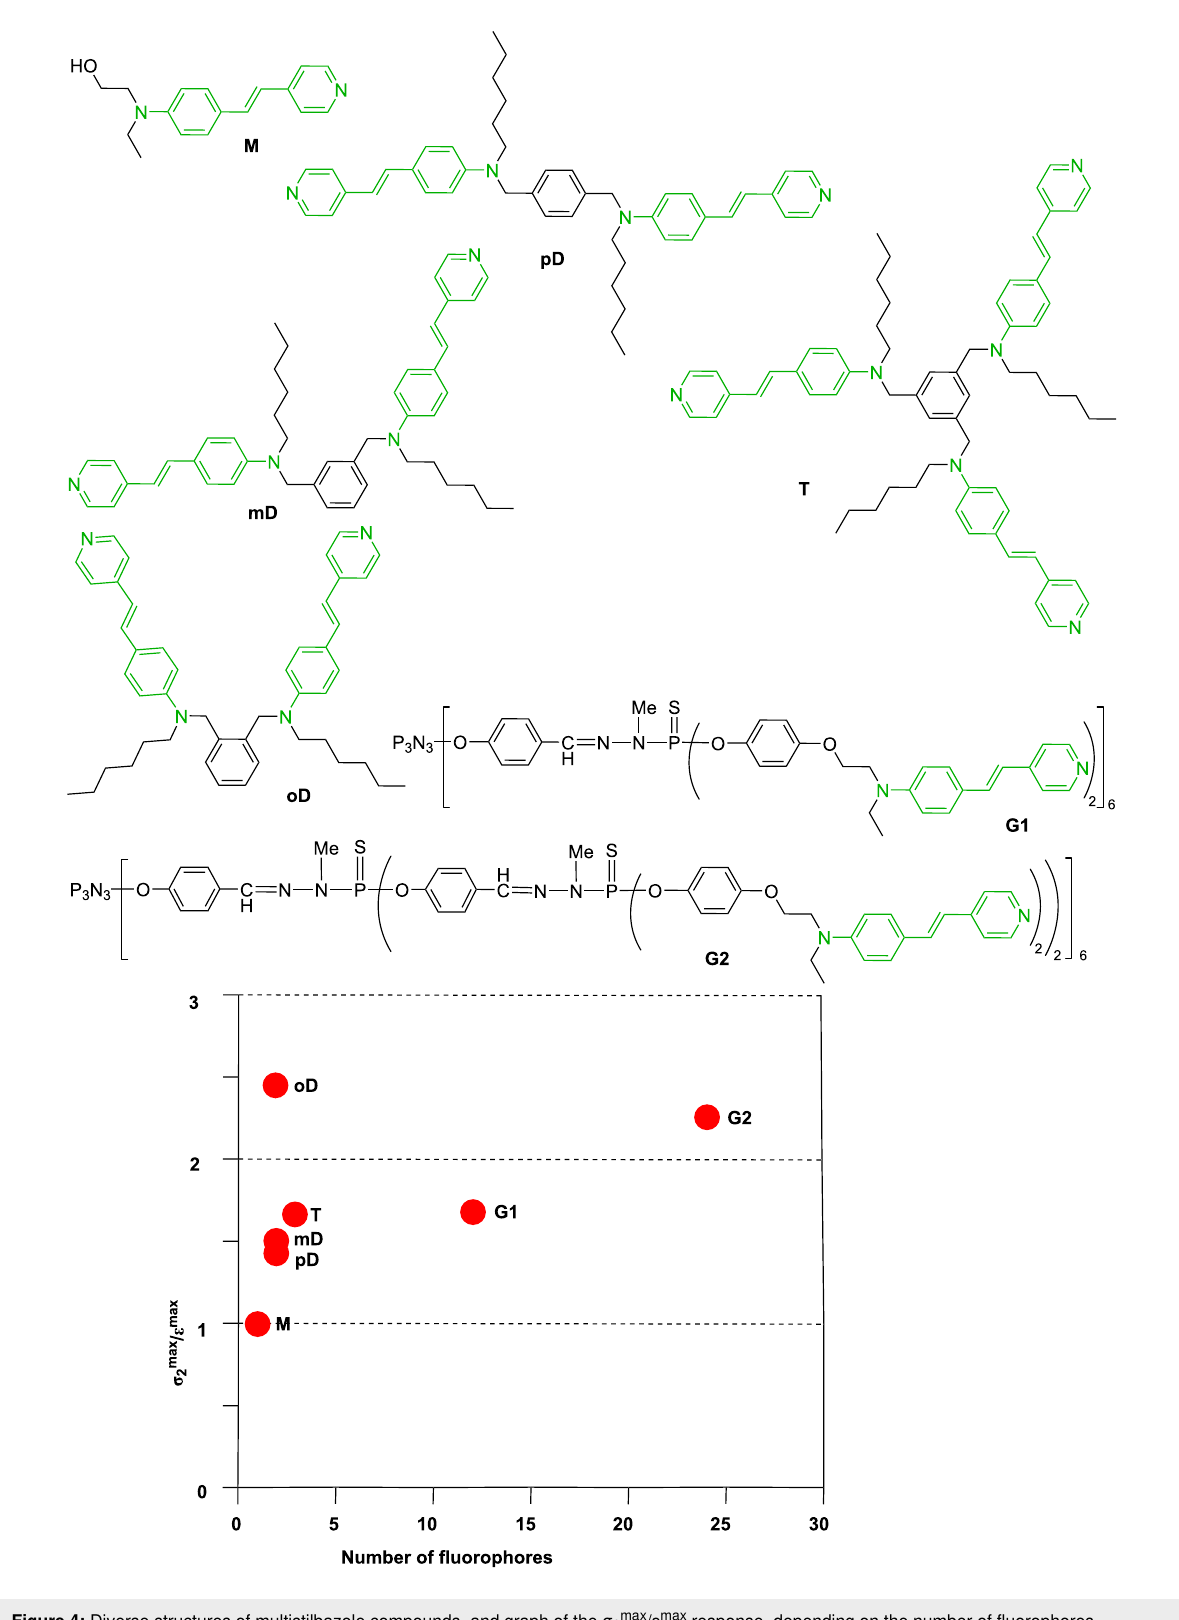
Figure 4: Diverse structures of multistilbazole compounds, and graph of the σ 2max / ε max response, depending on the number of